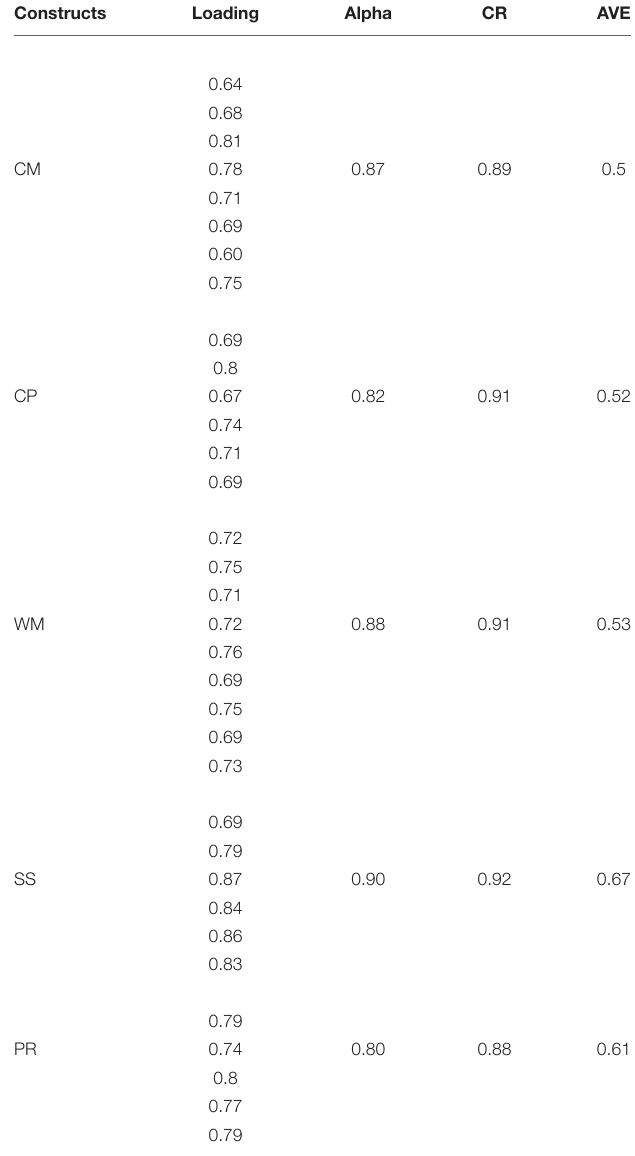
TABLE 1 | Reliability and validity of the construct.